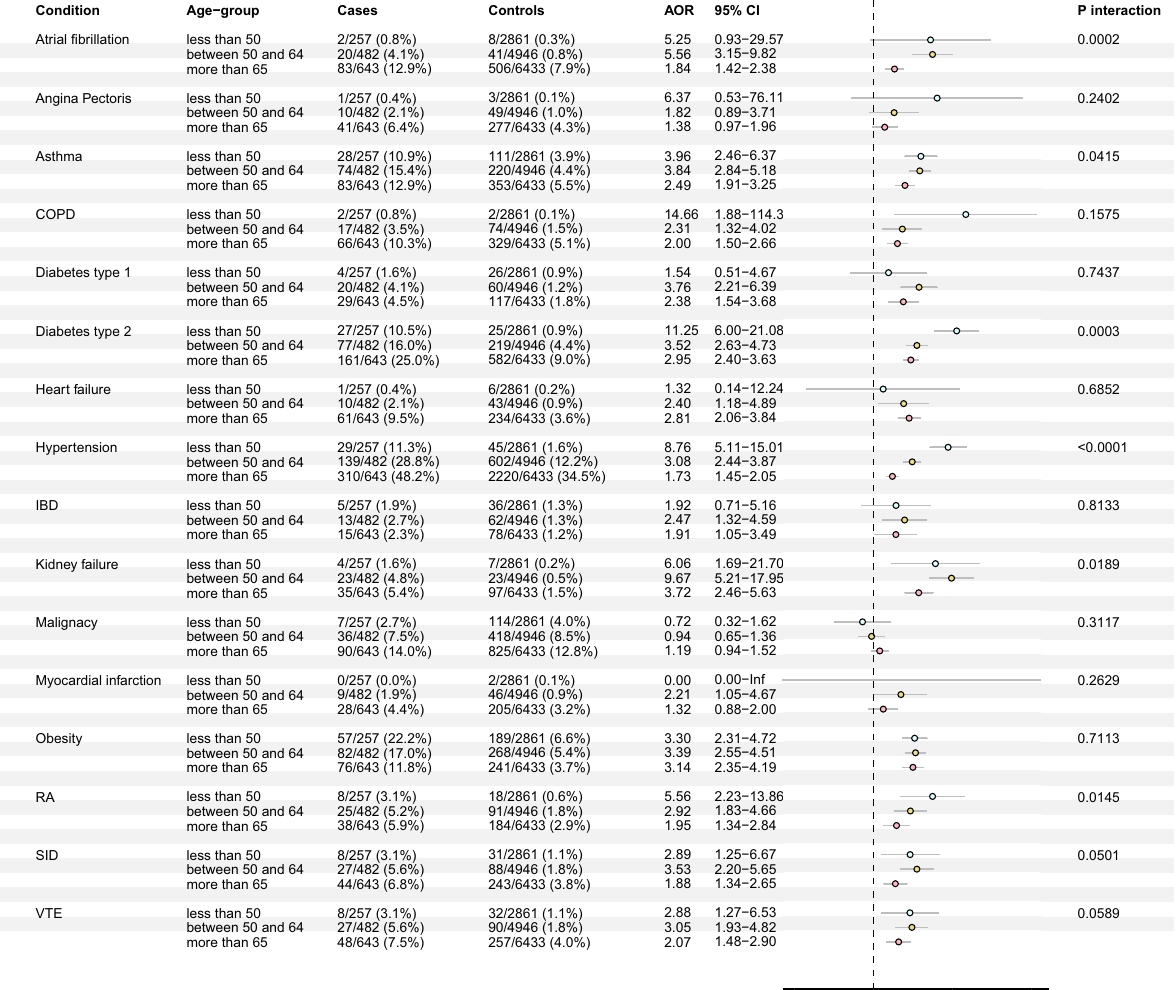
Fig. 2 Associations of pre-existing co-morbidities and severe COVID-19 (adjusted ORs with 95% CIs, and p-value for age interaction) in all three age groups of women. This fully adjusted model included co-variates of age, sociodemographic and socioeconomic variables (marital status, region of birth, disposable income, and educational level) for all